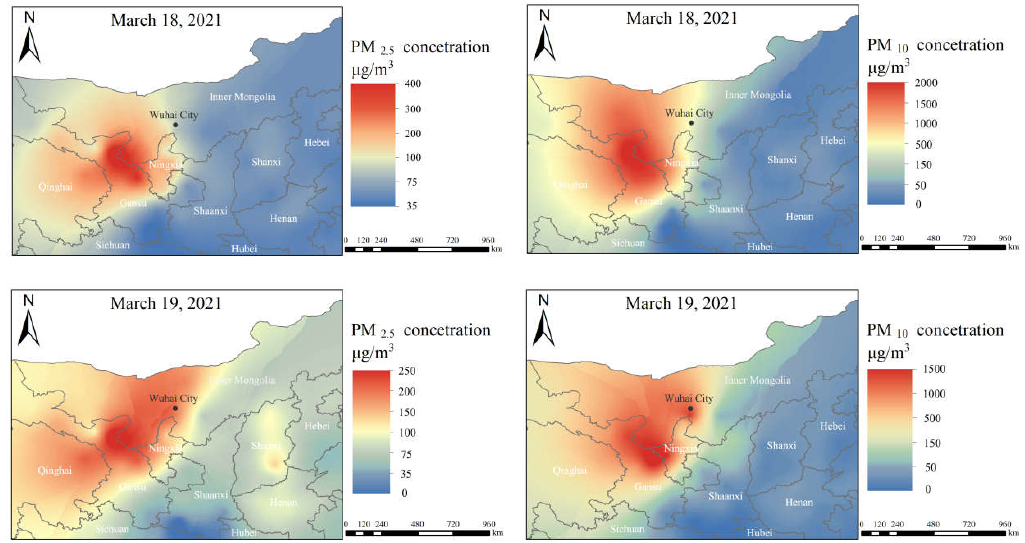
Figure 2. Spatial distribution of PM 2.5 and PM 10 concentrations during the sandstorm.